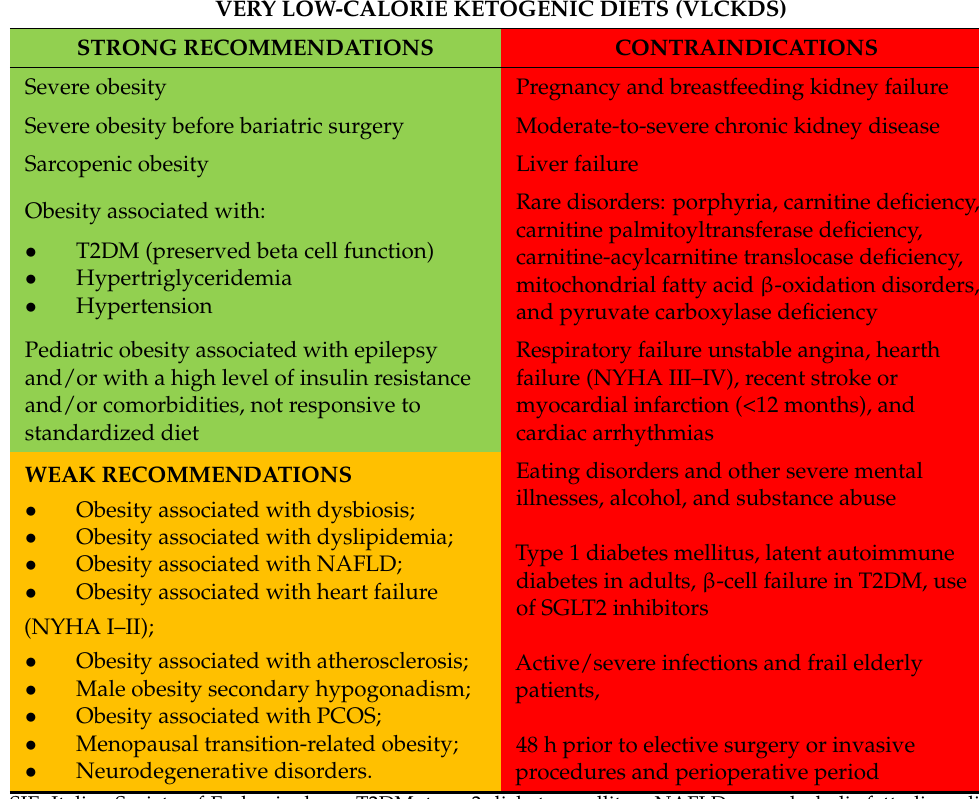
Table 1. Strong and weak indications and contraindications to VLCKD of